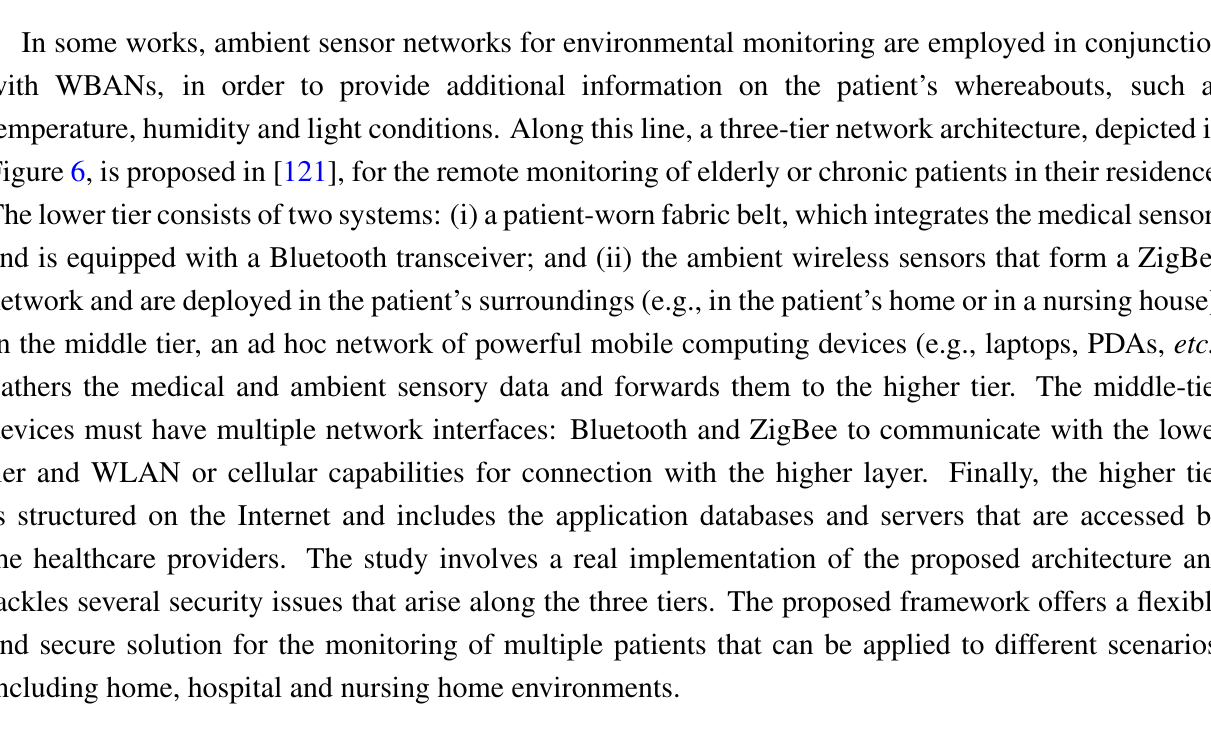
Figure 6. Example of three-tier network